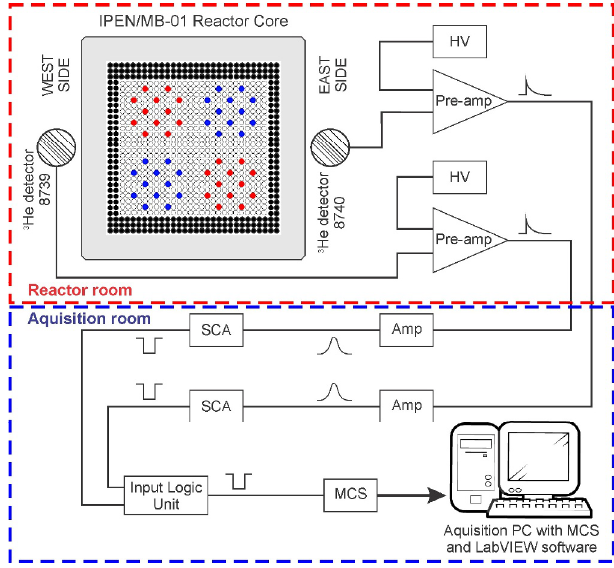
Figure 1. The IPEN/MB-01 configuration and the APSD Measurement